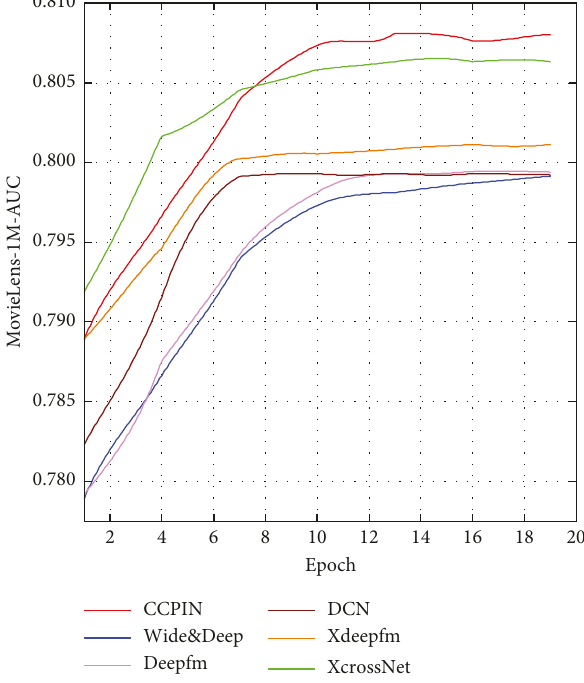
Figure 8: The CTR prediction performance of different models on the MovieLens-1M Table 2: Performance evaluation of parallel models on the dataset.